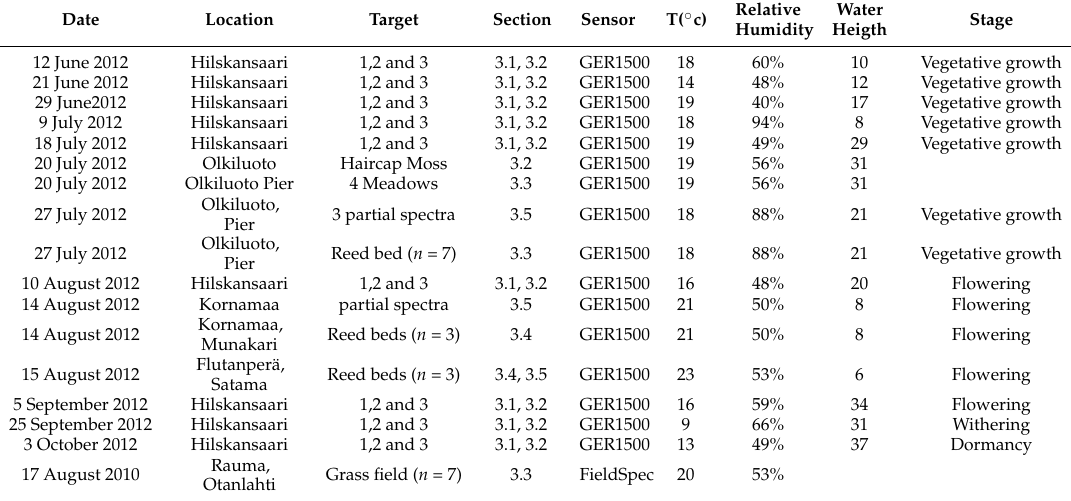
Table 1. Spectral field measurements used in this study. The water height is given in centimeters using a Finnish N2000 system. The temperature, humidity and water height data are the courtesy of Finnish Meteorological